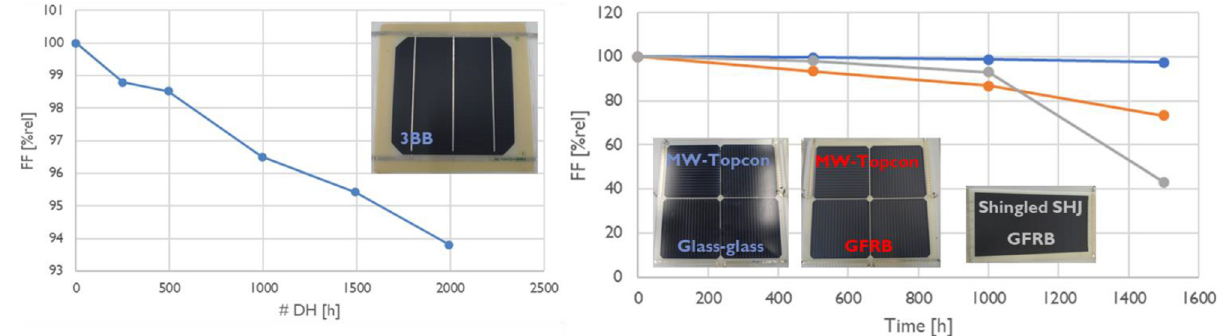
Fig. 14. Damp heat degradation of GFRB laminates compared to a glass-glass reference: a “ 3BB ” Al BSF cell (left), and Topcon and SHJ laminates